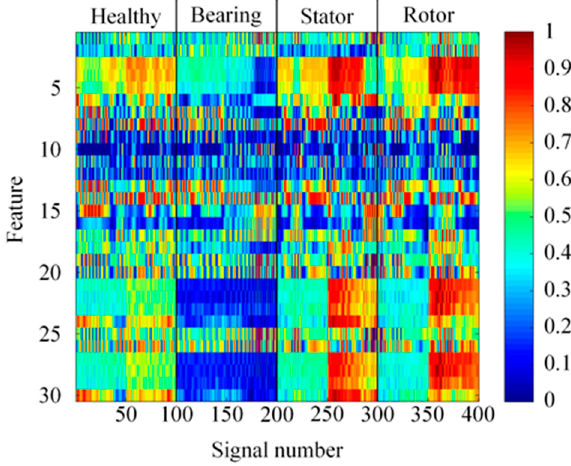
Figure 13. MRA feature energy diagram (SNR = 30 dB).